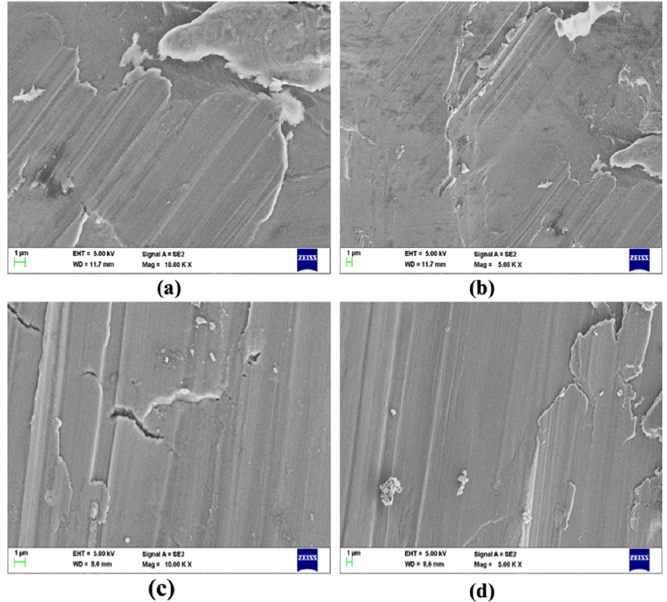
Figure 9. SEM micrographs of the worn surfaces of the Mg AZ91D hybrid composites ( a ) AZ91D + 0.5% CFs + 0.5% MWCNT composite with magnification 10.00 KX; ( b ) AZ91D + 0.5% CFs + 0.5% MWCNT composite with magnification 5.00 KX; ( c ) AZ91D + 0.75% CF’s + 0.75% MWCNT composite with magnification 10.00 KX; and ( d ) AZ91D + 0.75% CF’s + 0.75% MWCNT composite with